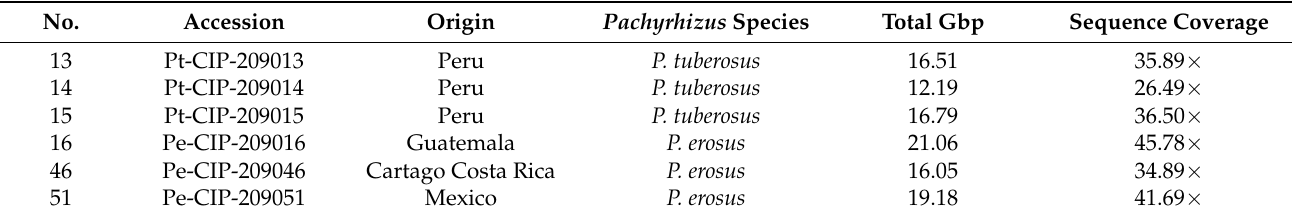
Table 1. Accession number, origin and species identity of the sampled yam bean cultivars. ‘Accession number’ is the tag used to designate each species, ‘Origin’ documents where the original plant seeds come from, and ‘ Pachyrhizus species’ describes which species the cultivars are. All the species were obtained from the International Potato Center (CIP) in Peru.